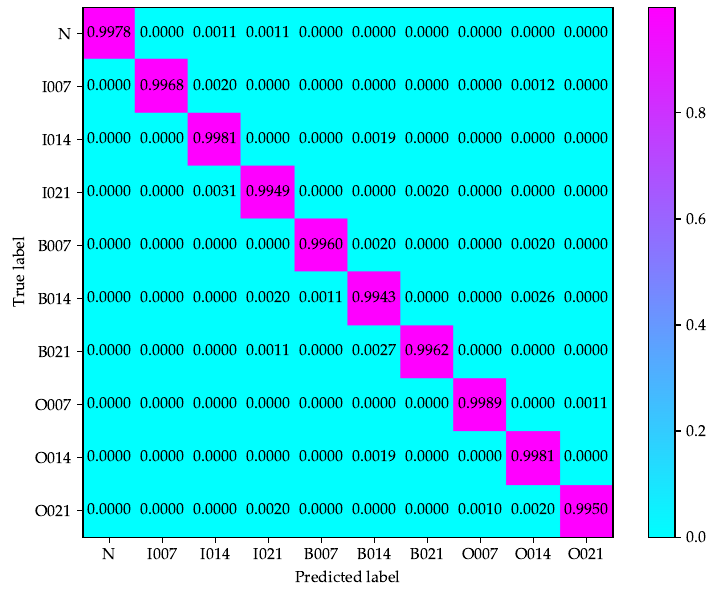
Figure 10. Confusion matrix of test samples used in the improved 1D LeNet-5 network.